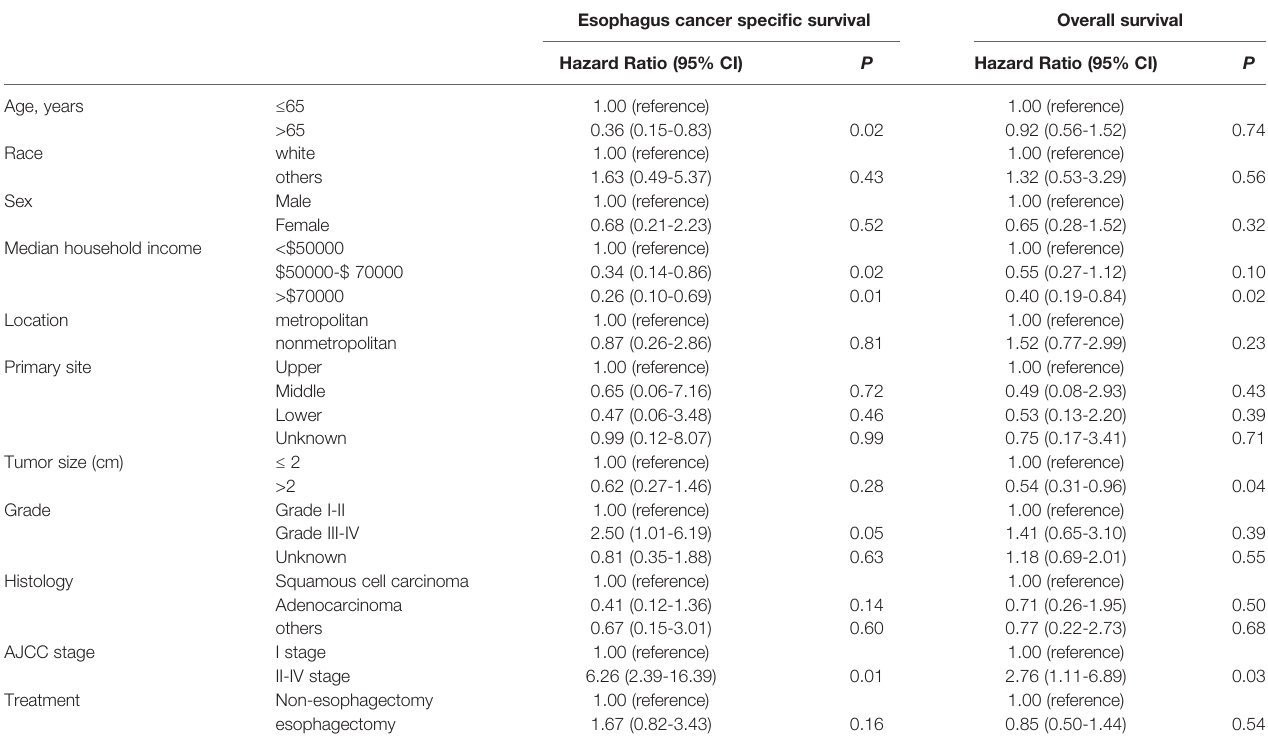
TABLE 4 | Cox proportional hazards regression model analysis for ECSS and OS in T1a stage esophagus cancer